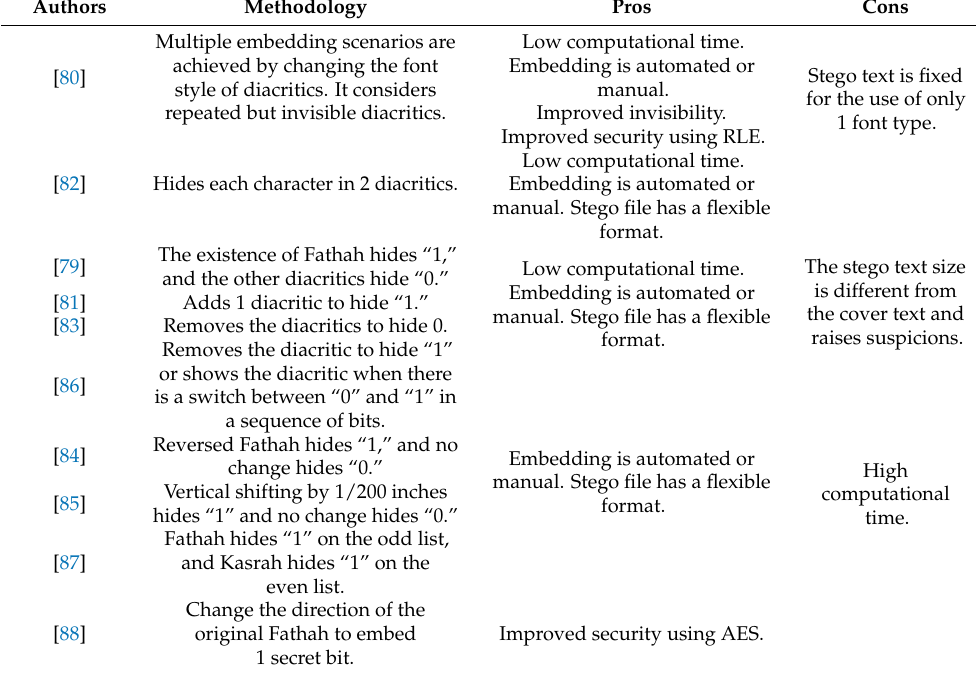
Table 10. A summary of the reviewed articles on the diacritics method.